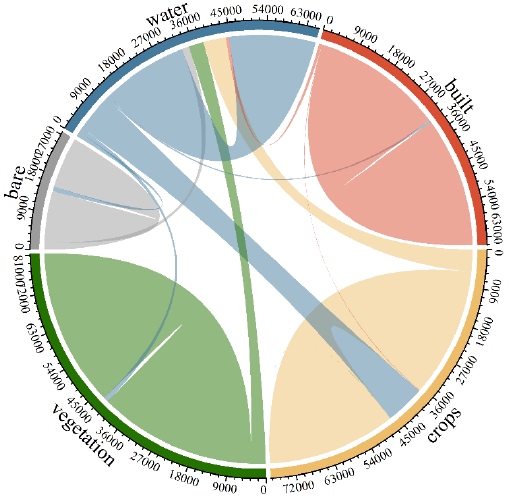
Figure 5. Impact analysis of various ground features caused by flood disasters.